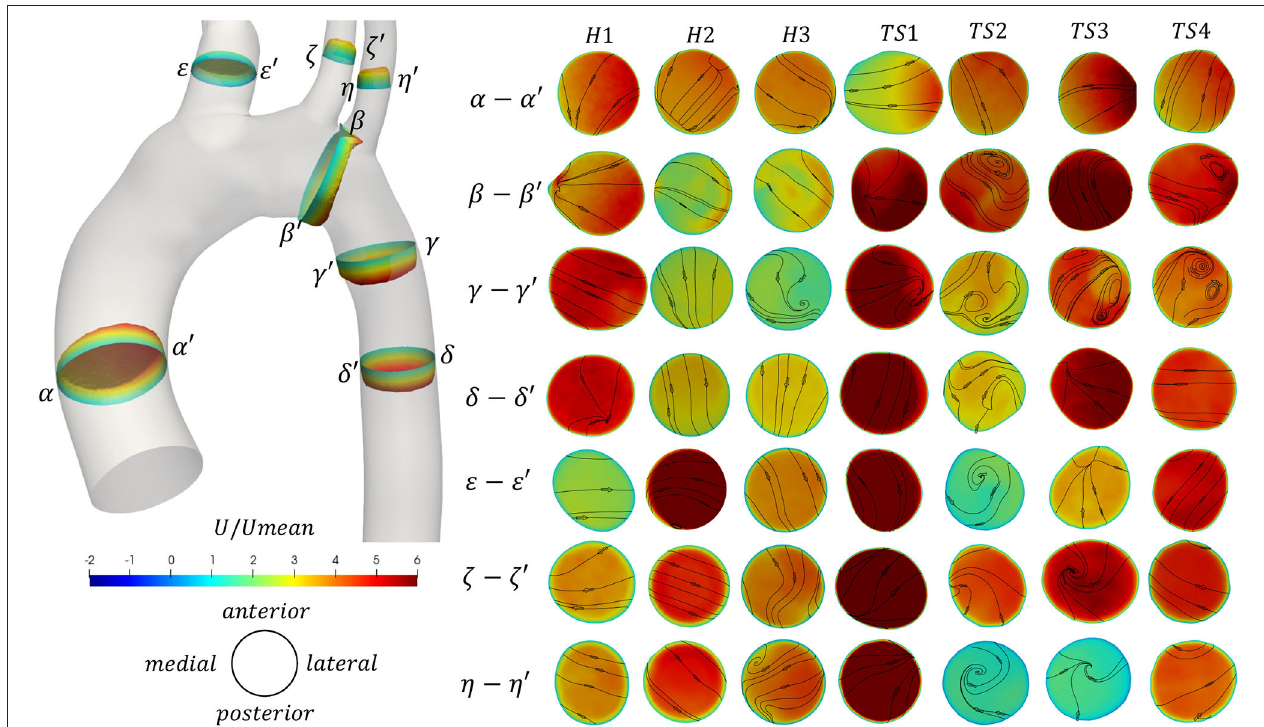
FIGURE 5 | (Left) Through-plane velocity profiles and (Right) contours of through-plane velocity overlayed by vectors of in-plane velocity on seven cross-sections α - α ′ to η - η ′ along the aorta [locations shown on the 3D healthy (H1) model]. Contours colored by non-dimensional axial velocity at peak velocity for the healthy (H1–H3) and Turner syndrome (TS1–TS4) girls. Cross-sections are oriented looking downstream, with the top and bottom edges corresponding to the anterior and posterior sides of the aorta, respectively, and the left and right points as shown on the left. Cross-sections are not to scale.